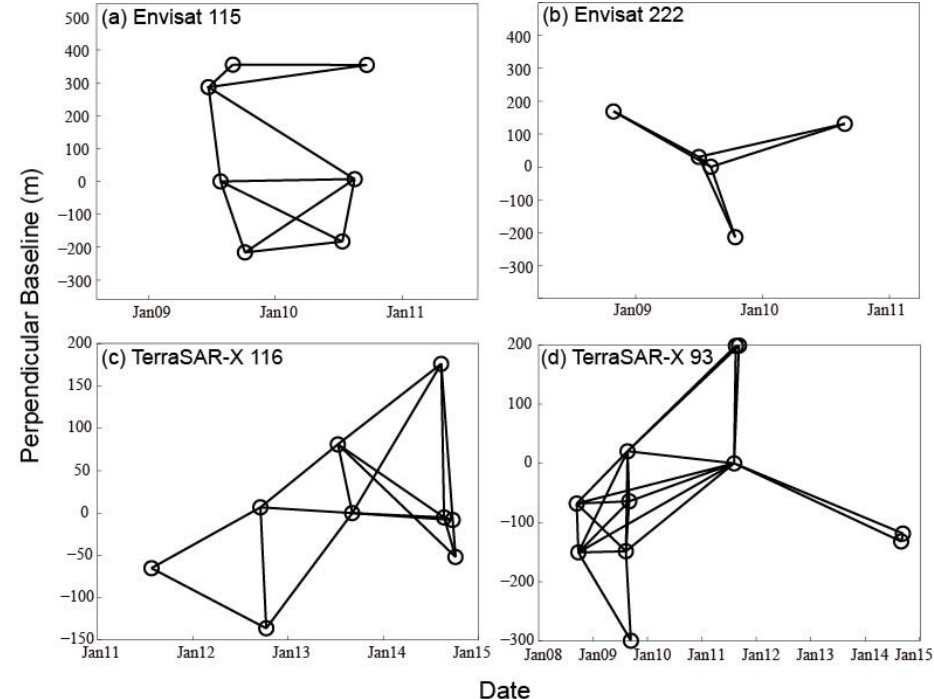
Figure 2. Temporal-spatial baseline distributions of interferograms for the four datasets: ( a , b ) interferograms with perpendicular baselines less than 300 m for ENVISAT C-band data, and ( c , d ) interferograms with perpendicular baselines less than 200 m for TerraSAR-X X-band data. Table 1. SAR data characteristics in Okmok.